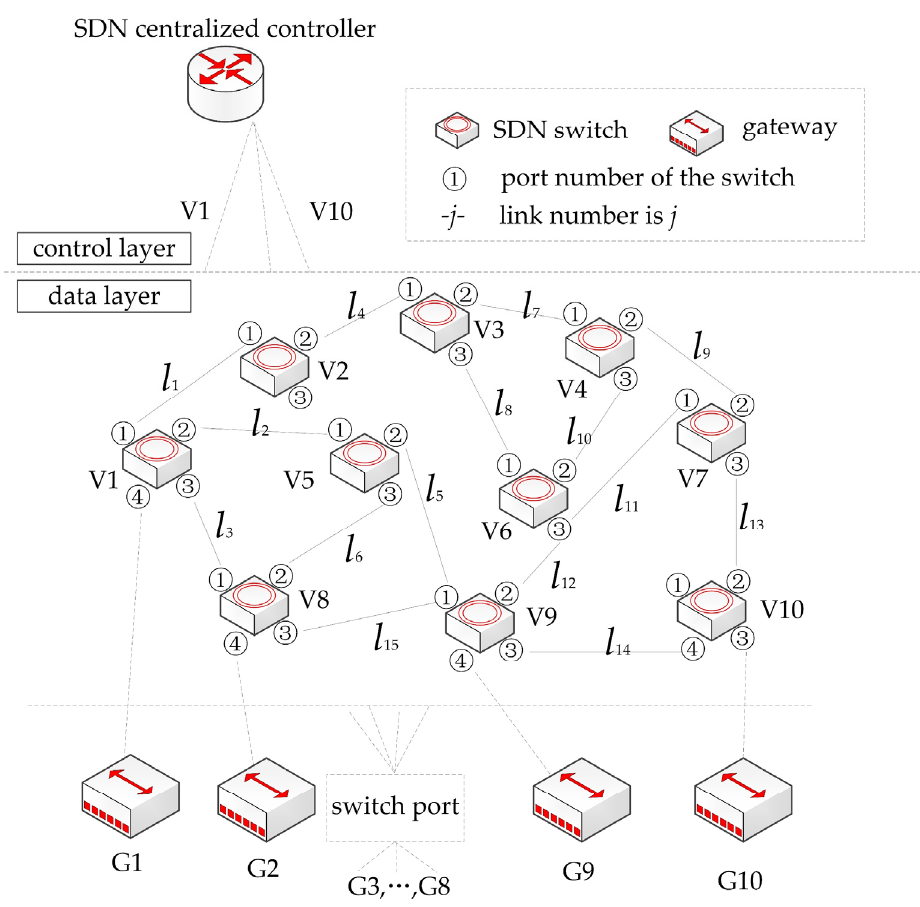
Figure 2. The LoRaWAN downlink modeling topology based on the SDN framework.